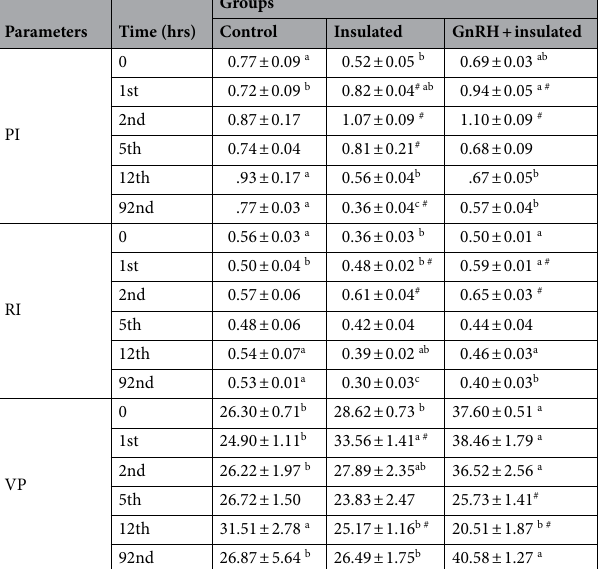
Table 4. Interaction between the insulation (with and without GnRH injection) and time on PI, RI and VP in bucks. a,b,c Means with different small superscript letters in the same row are significantly different ( p < 0.05) (Duncan test). # Significant different as compared to zero time in the same group (Paired T- test).